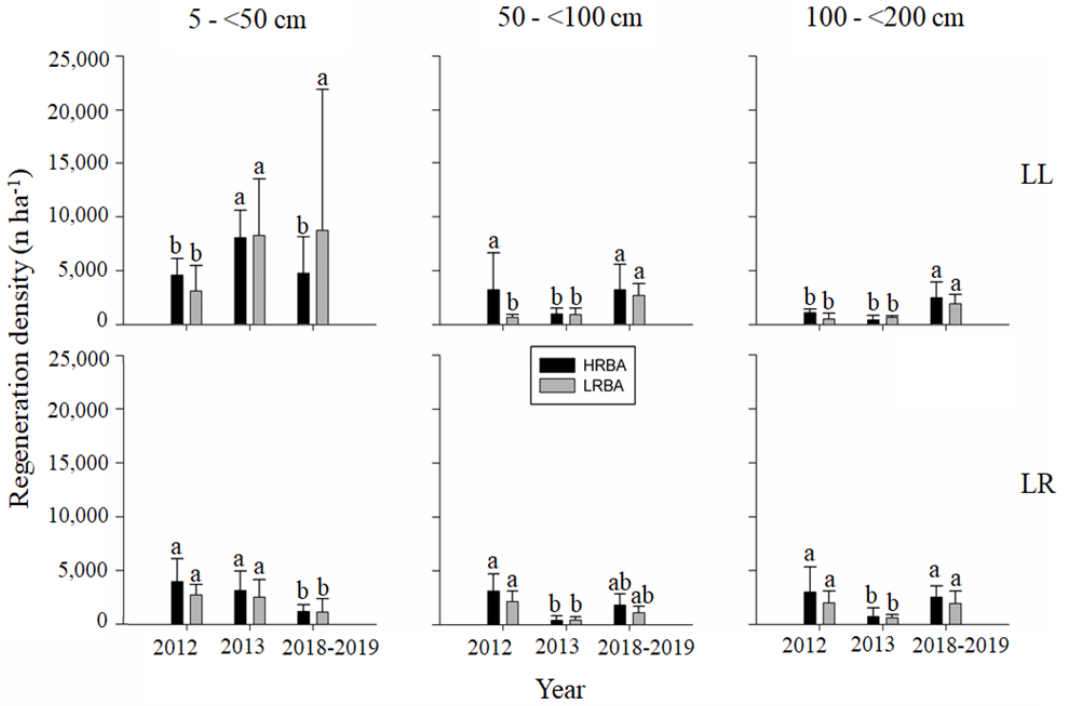
Figure 6. Mean (bars) and standard deviation (whiskers) in the density of seedlings (n ha − 1 ) for mid-tolerant species according to height classes (5– < 50 cm; 50– < 100 cm; 100–200 cm), year, treatment, and site. Di ff erent letters between bars of the same color show significant di ff erences between measurement years ( p -value < 0.05).